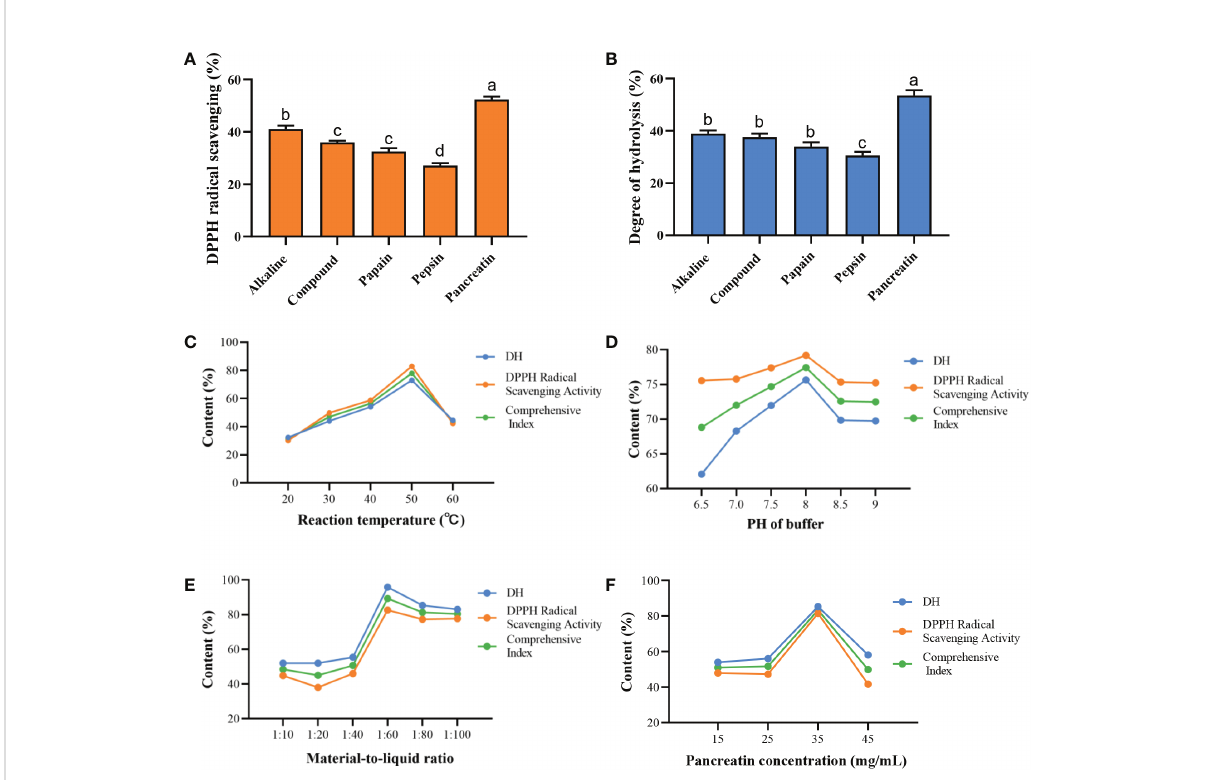
FIGURE 1 Preparation of protein enzymatic hydrolysates of C-PC. Effects of different proteases on the (A) DPPH radical scavenging activity. (B) Degree of hydrolysis (DH). DH and DPPH radical scavenging activity vary with effects of (C) Reaction temperature. (D) PH of buffer. (E) Material-to-liquid ratio. (F) Pancreatin concentration. a-d Values with the different letters indicate a signi fi cant difference ( p <